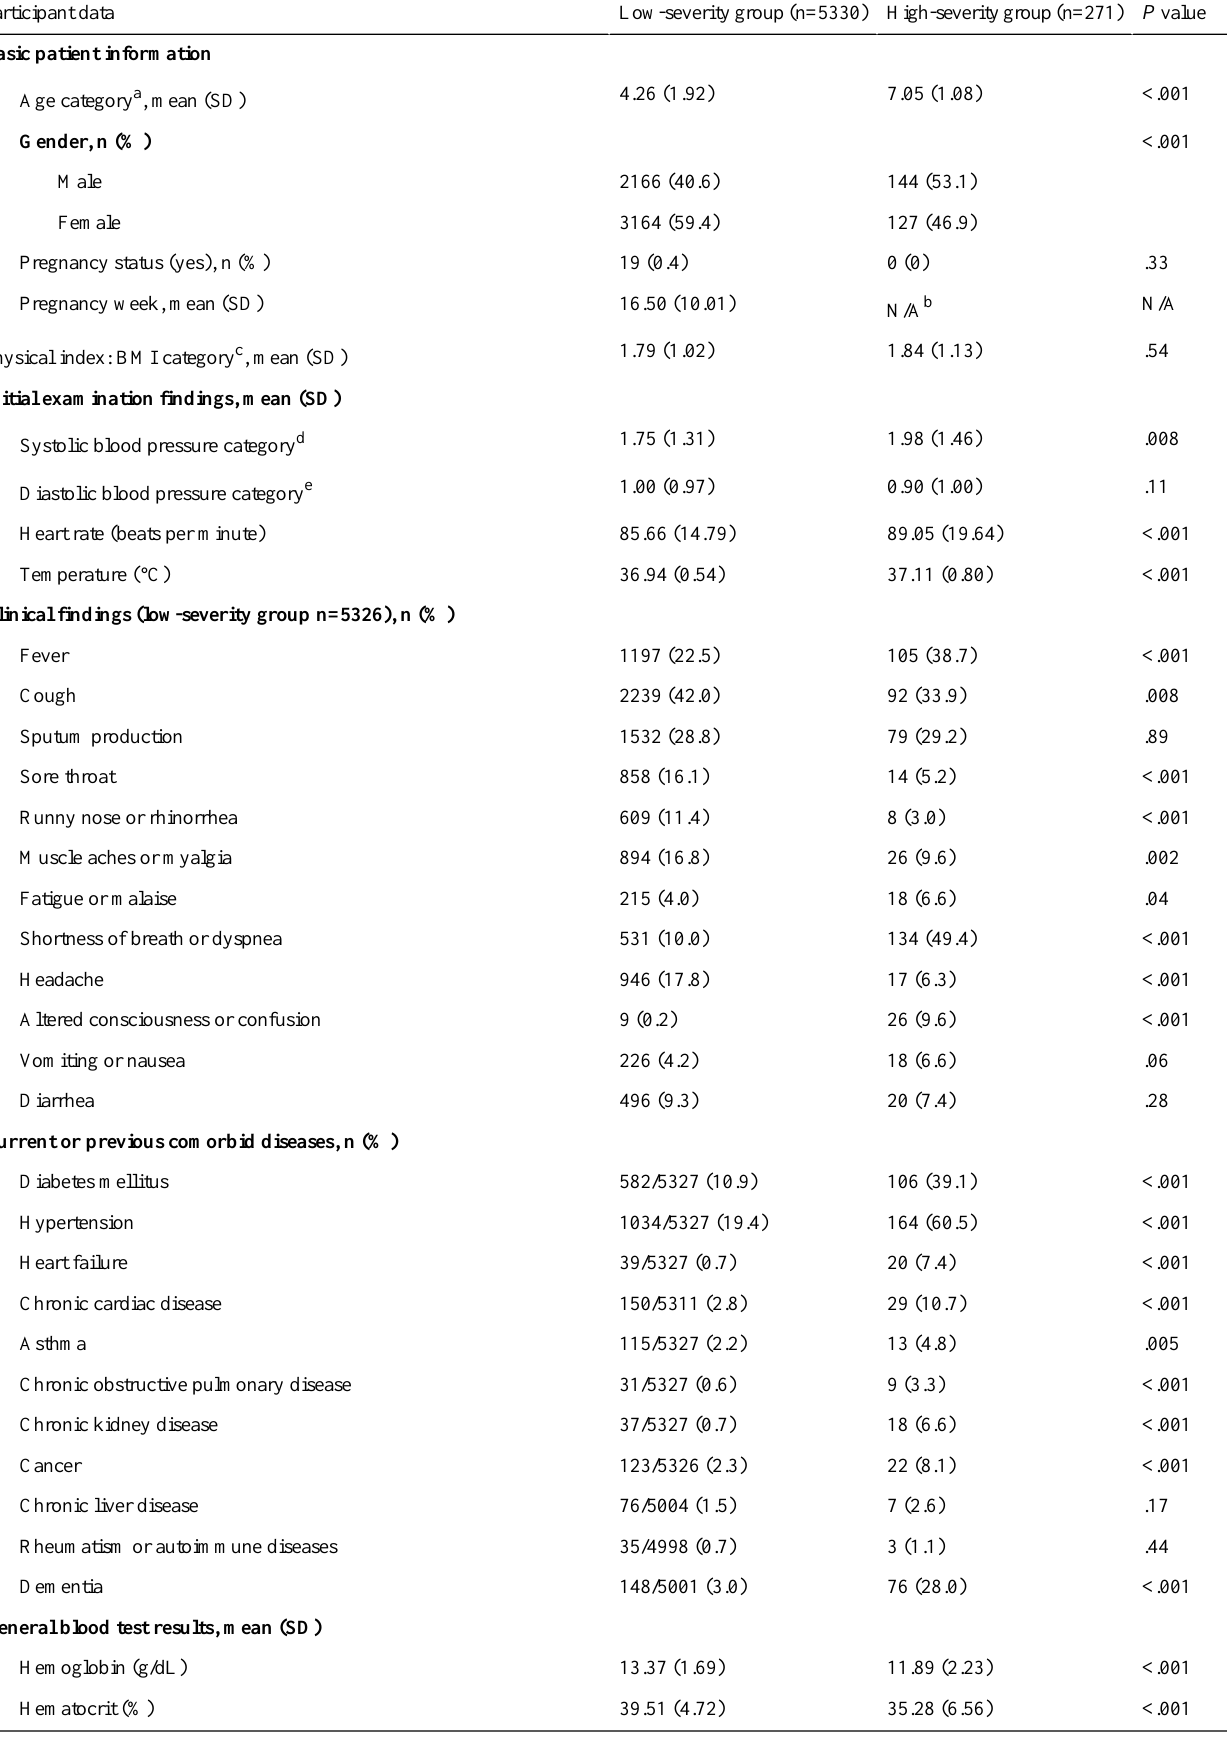
Table 2. Statistical summary of clinical features from the low-severity group and high-severity group